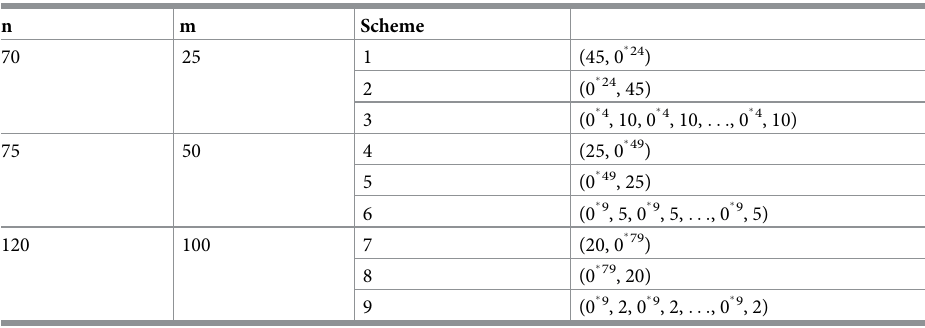
Table 1. Censoring scheme R = ( R 1 , R 2 , ... , R m ). n